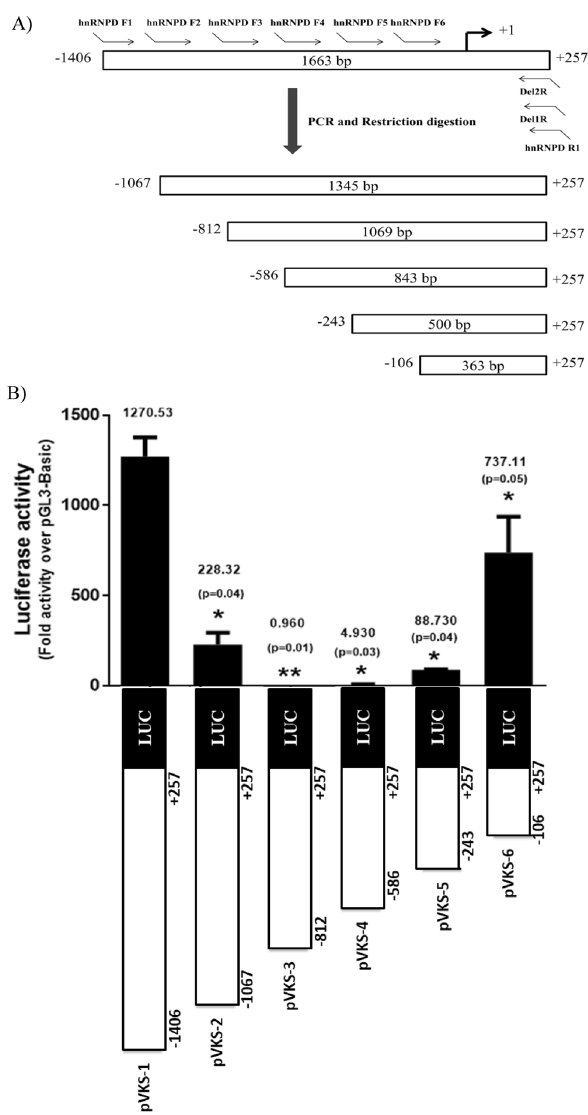
Figure 3. Deletion analysis of hnRNPD promoter. ( A ) Schematic diagram for generation of various deletions constructs of human hnRNPD promoter. ( B ) A series of promoter fragment having a common 3 ʹ end (+ 257) but 5 ʹ lacking increasing number of nucleotides (− 1088, − 824, − 605, − 255 and − 126) were PCR amplified as described in Materials and Methods and cloned separately upstream to luciferase reporter gene in pGL3-Basic plasmid to generate deletion constructs pVKS-2, pVKS-3, pVKS-4, pVKS-5 and pVKS-6 respectively. The individual constructs were co-transfected with pRL-TK plasmid in SCC-4 cells and the luciferase activities were measured 48 h post-transfection. Other details are same as described in Fig. 1. Values are mean ± SD from four independent experiments performed in triplicate. The results were statistically analyzed using a paired two tailed Student’s t-test and values significantly different from pVKS-1 have been marked by stars (**P ≤ 0.01, *P ≤